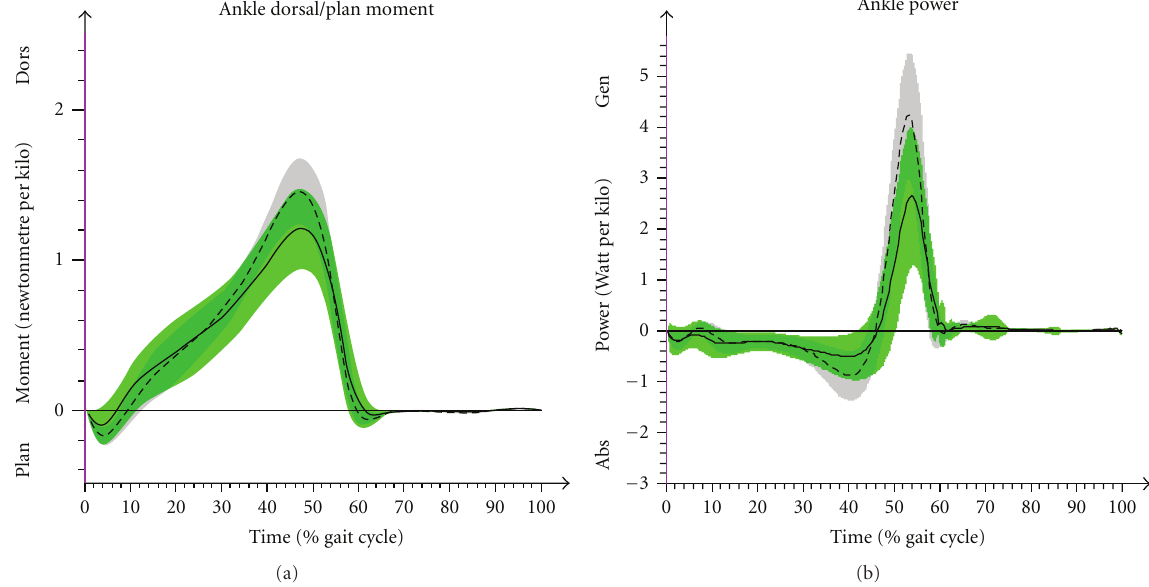
Figure 6: It shows kinetic results of CG (arithmetic mean & SD (---)) and JIA-P (arithmetic mean & SD (—)) in time normalized (%) gait cycle of the ankle. (a) Ankle moment (dorsal/plantar flexion). (b) Ankle power.